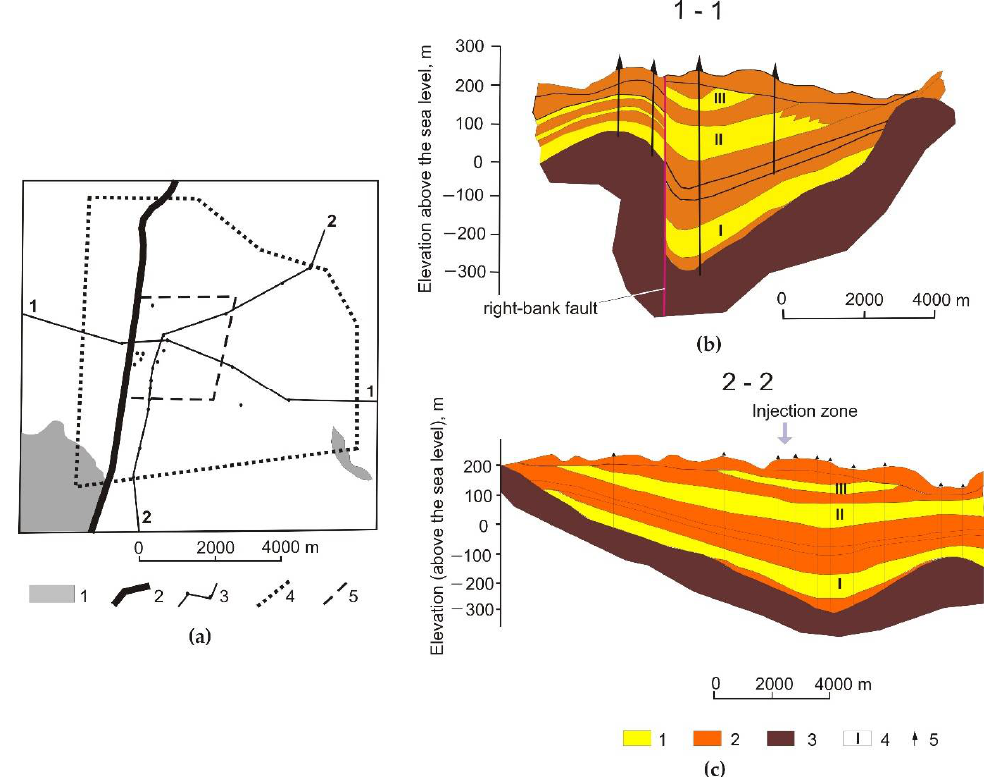
Figure 3. Cross-sections of the underground medium at the injection site for disposal of LRW from MCP after [5]. ( a ) Schematic diagram of the injection site; (1) basement rocks, (2) right-bank fault, (3) cross-section lines and exploratory wells, (4) boundary of the sanitary protection zone, and (5) boundary of the LRW disposal site. ( b , c ) Schematic hydrogeological cross-sections along the lines 1-1 and 2-2 (see ( a